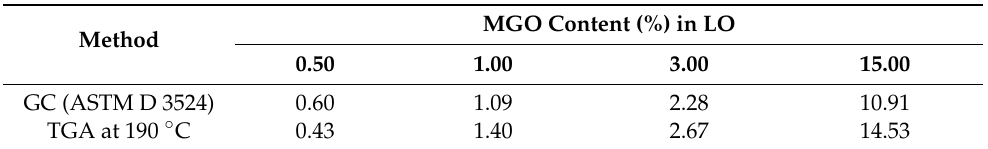
Table 3. Comparison of gas chromatography (GC) and TGA methods for determining marine gas oil (MGO) content in lubricating oil (LO).